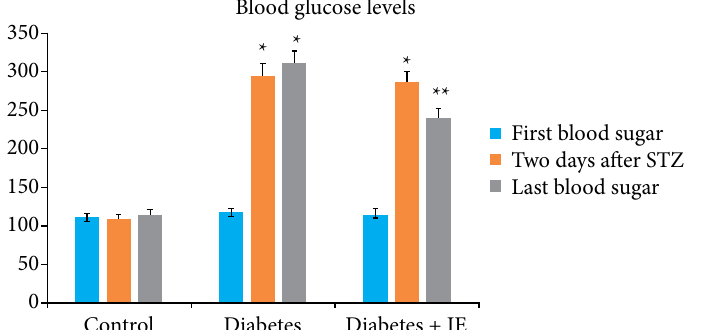
Figure 1 – Blood glucose levels of control, diabetes, and diabetes +IE. *p < 0.0001 compared to the control group; **p < 0.05 compared to diabetes group. Table 2 – Effect of intensive exercise on blood glucose and serum testosterone levels in the rat testis after STZ-induced diabetes. Control (n =